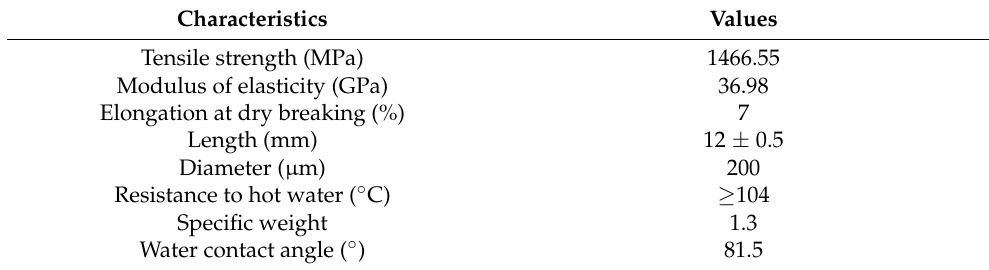
Table 2. Characteristics of PVA Fibres.